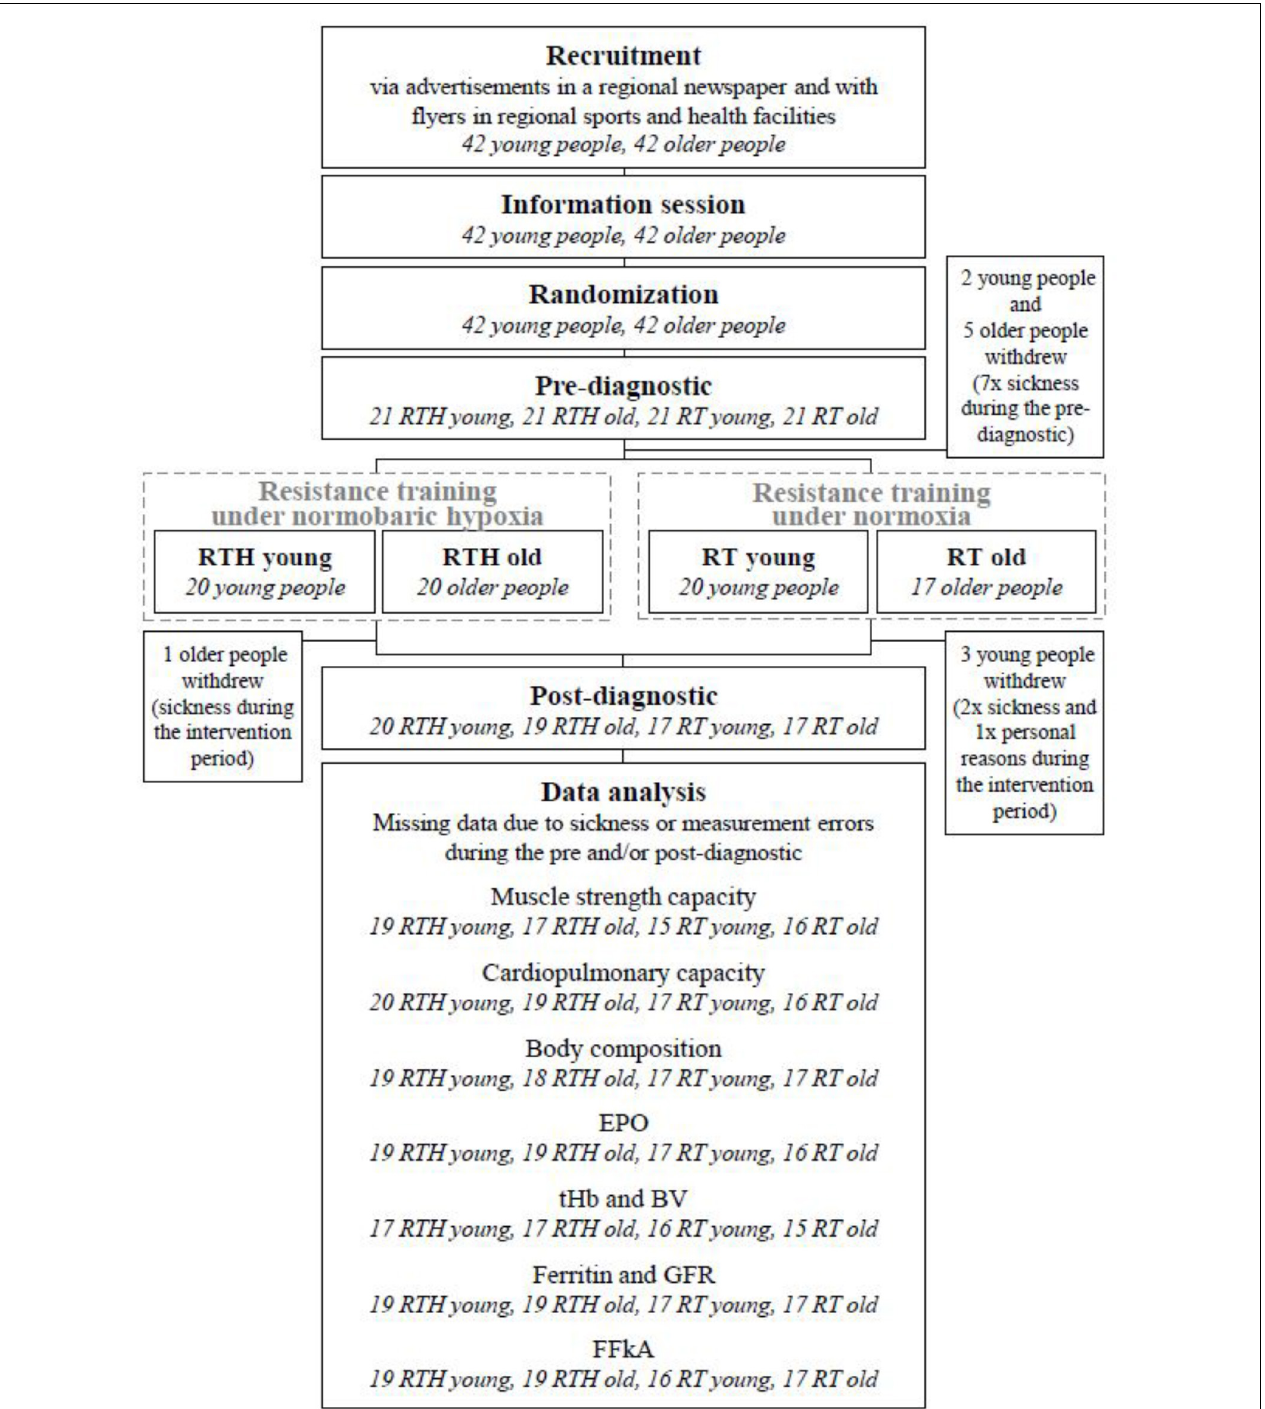
FIGURE 2 | CONSORT flow chart [blood volume (BV), erythropoietin (EPO), glomerular filtration rate (GFR), questionnaire for physical activity “Freiburger Fragebogen zur körperlichen Aktivität” (FFkA), total hemoglobin mass (tHb)].